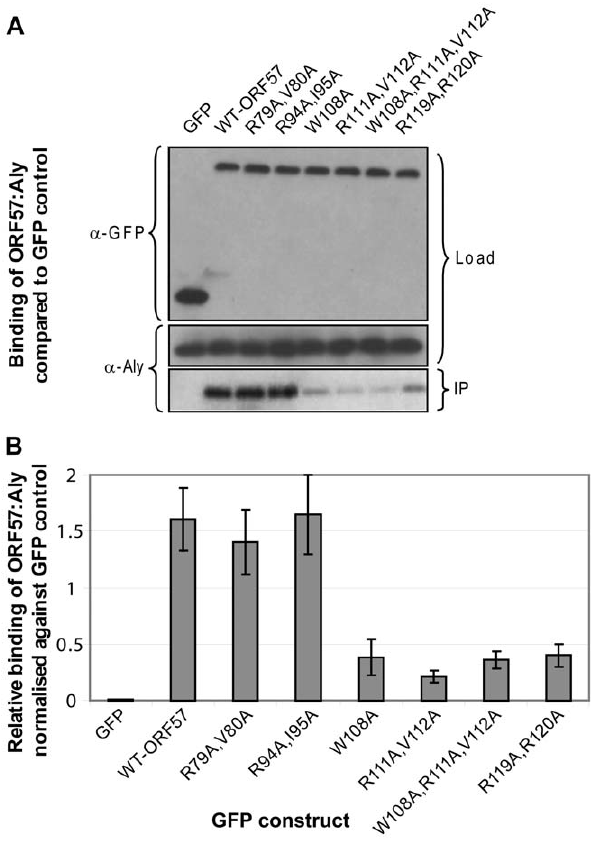
Figure 7. Functional importance of triad residues 105, 107 and 108 for the interaction of ICP27 with human Aly. (A) Co- immunoprecipitation assays were performed on 293T cells transfected with GFP-tagged ICP27 and its mutants. Mutations probed triad residues identified in the experimental structure formed between short protein fragments of ICP27 and REF. Cell lysates were incubated with Protein A agarose and a polyclonal GFP-specific antibody and precipitated proteins were analyzed by Western blotting with Aly- specific antibody and a monoclonal antibody specific to GFP as a loading control. (B) The relative binding affinities from 3 independent experiments were analysed quantitatively by densitometry. Point mutations of the REF recognition triad residues all significantly decrease binding between full-length ICP27 and endogenous Aly, confirming the functional significance of these residues identified by NMR.